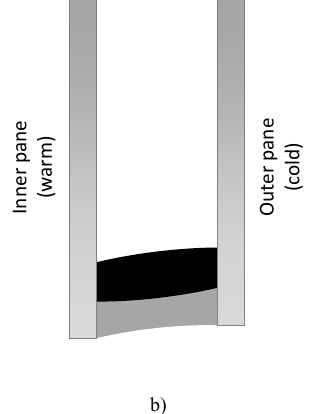
Fig. 19 Deformation of an IGU with Ködispace 4SG spacer, a) undeformed, b)